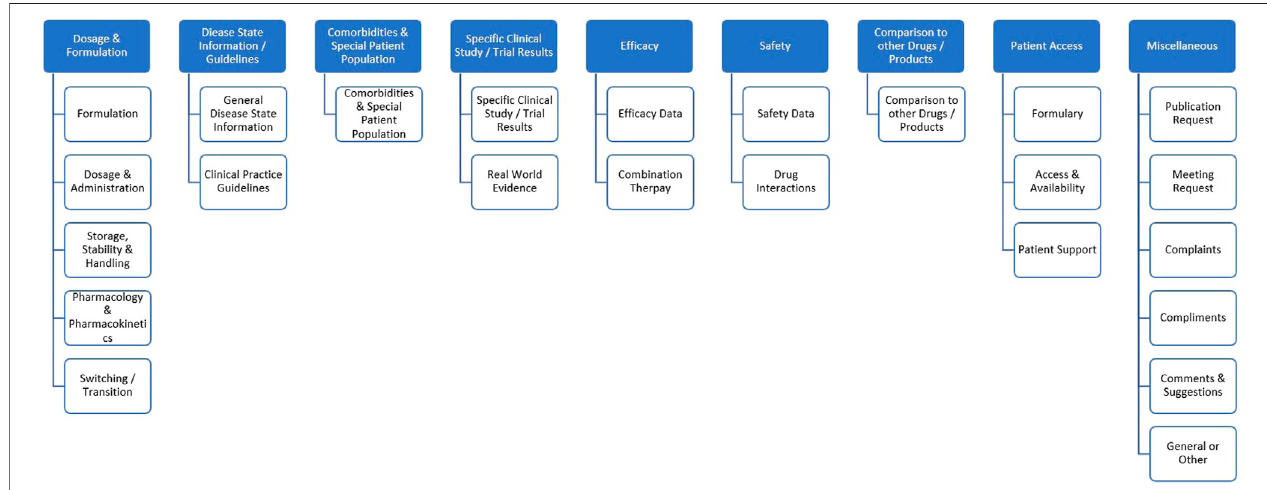
FIGURE 2 | Categorization hierarchy used to label the inquiries. For the sake of algorithm development, only the sub-categories (i.e., level 2) were used.